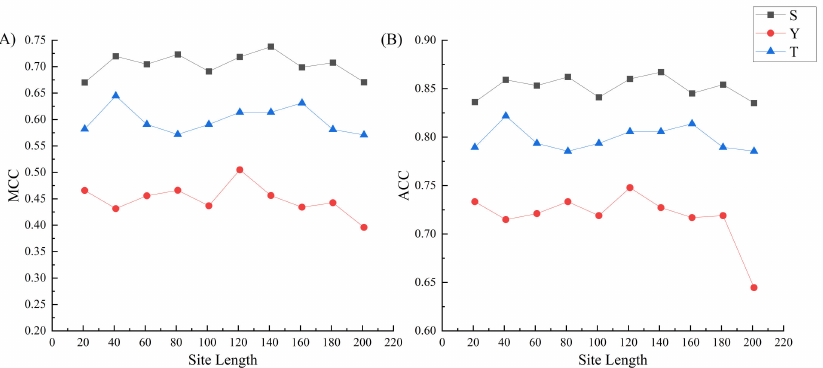
Figure 4. The performance of the models based on different phosphorylation peptide lengths. ( A ) The MCC values of the models on ten phosphorylation peptides lengths. ( B ) The ACC values of the models on ten phosphorylation peptides